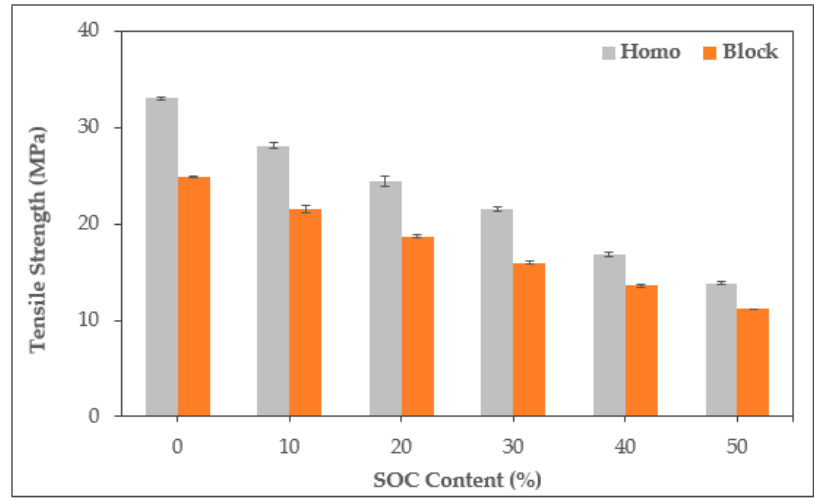
Figure 6. Tensile strength of PP/SOC specimen.